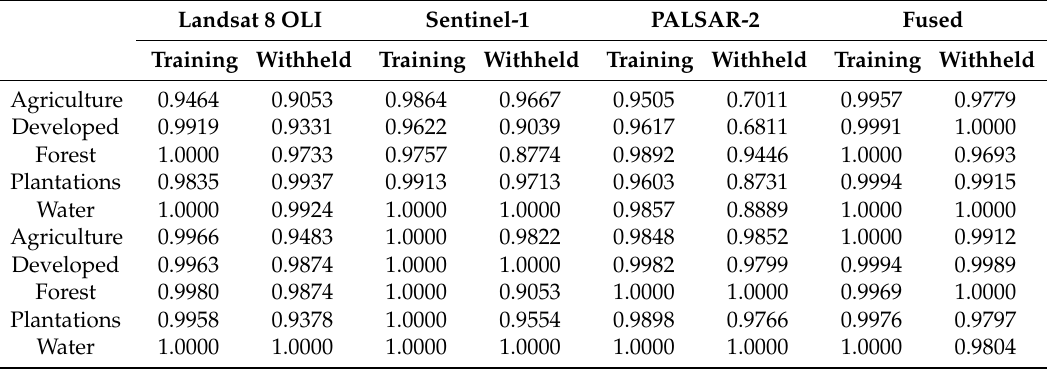
Table 3. Area under the curve (AUC) values for (top) Tanintharyi and (bottom) West Kalimantan. Landsat 8 OLI Sentinel-1 PALSAR-2 Fused Training Withheld Training Withheld Training Withheld Training